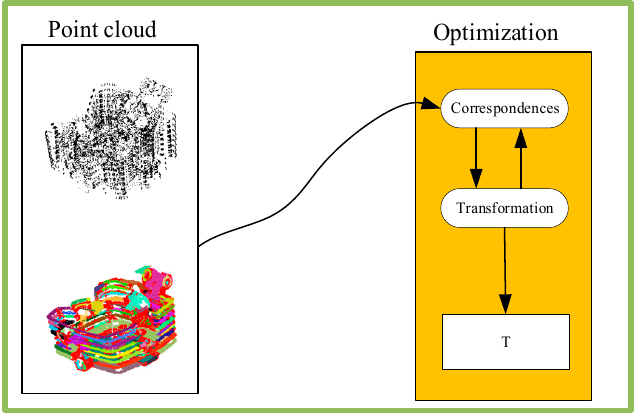
Figure 17. Optimization-based registration method.